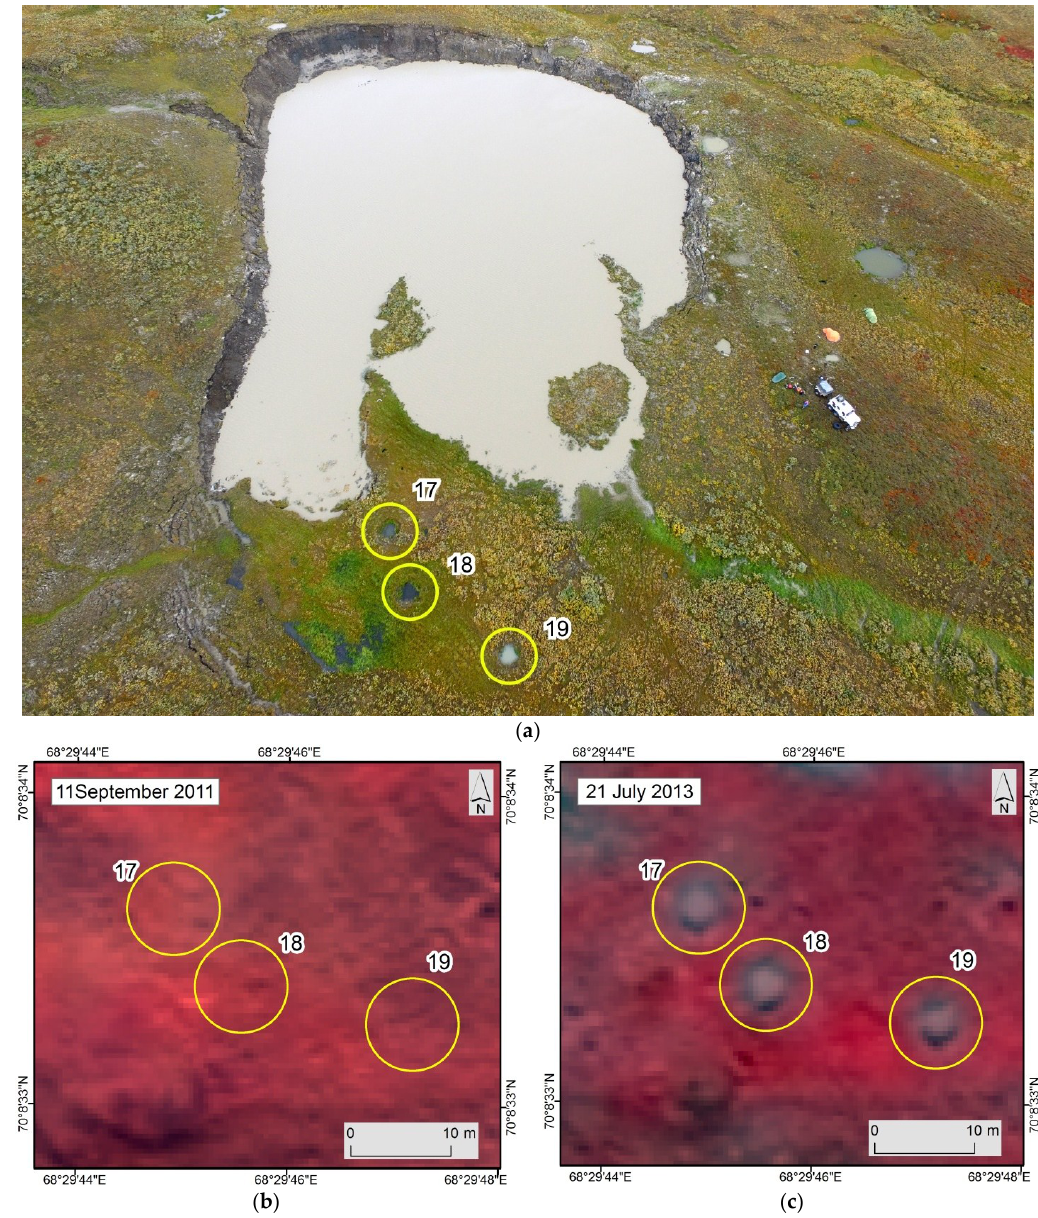
Figure 10. Impact hollows 17, 18 and 19, located 85–100 m south of the GEC-2 AMP: ( a ) an oblique photograph from the UAV of 07 September 2017; ( b ) no impact hollow before the formation of GEC-2 on WorldView-2 image of 11 September 2011, synthesis of NIR + Red + Green; ( c ) impact hollows, which appeared on WorldView-2 of 21 July 2013, synthesis of NIR + Red + Green. Numbers indicate impact hollows in accordance with Figures 7 and 8.